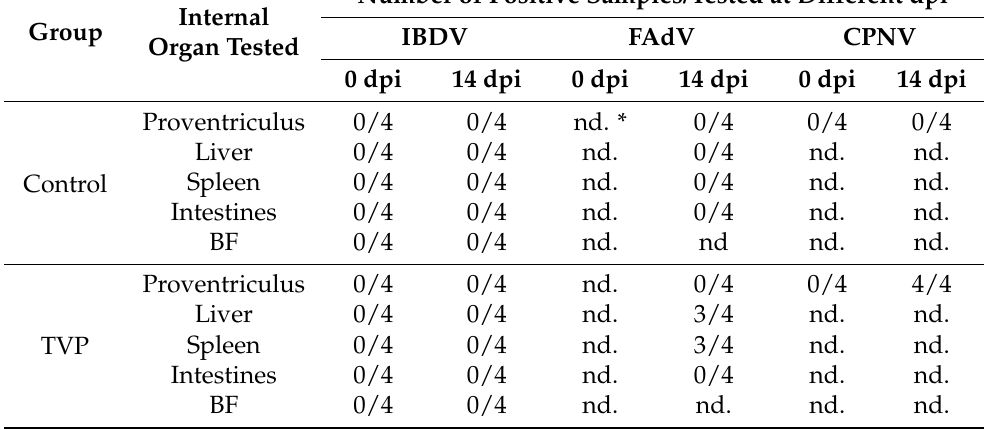
Table 5. Results of molecular studies. Table presents the results of IBDV, FAdV and chicken proven- tricular necrosis virus (CPNV) prevalence in the internal organs of birds of Control and TVP groups at different